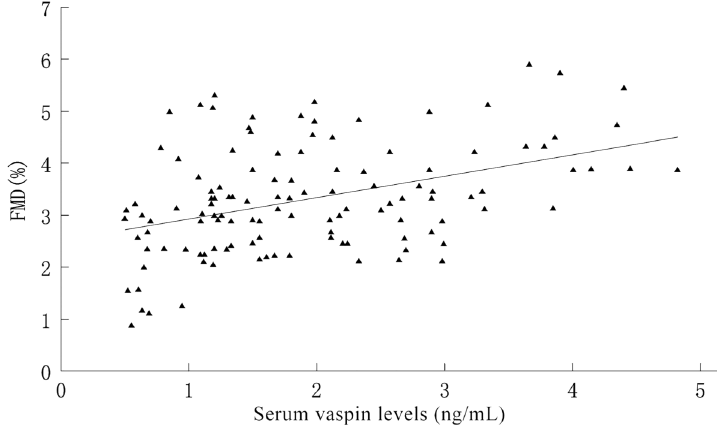
Figure 1. Correlation between serum vaspin levels and fl ow-mediated dilation (FMD) in patients with ankylosing